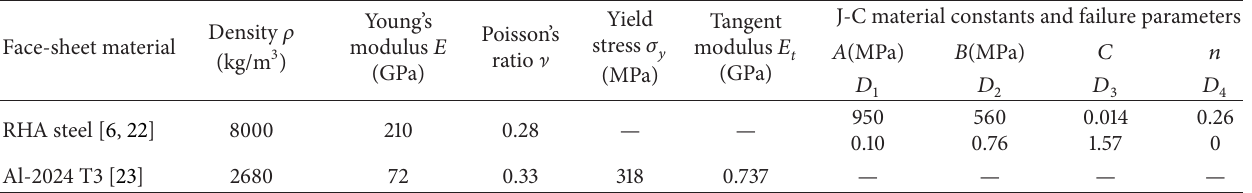
Table 1: Mechanical properties, J-C model constants, and failure parameters for the face-sheet materials of the curved sandwich panel. Density Face-sheet material